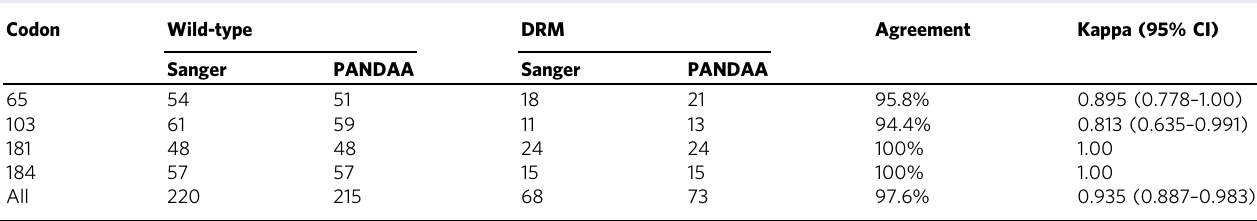
Table 3 Agreement between PANDAA and population sequencing for four DRMs.